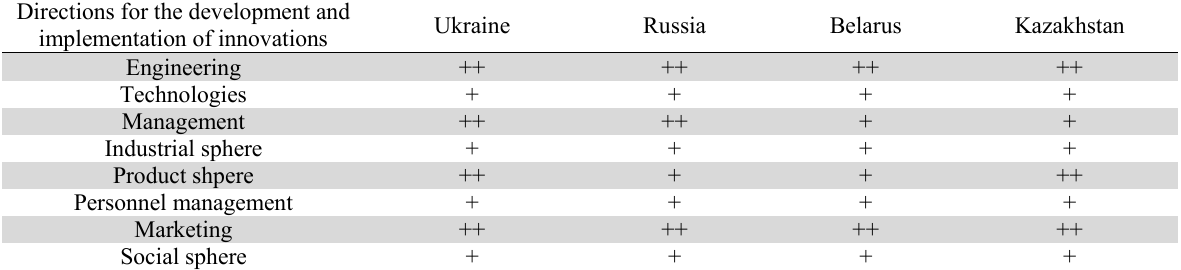
Assessment of directions for the development and implementation of innovations in motor transport en- terprises in key countries of the post-Soviet economic space Directions for the development and implementation of